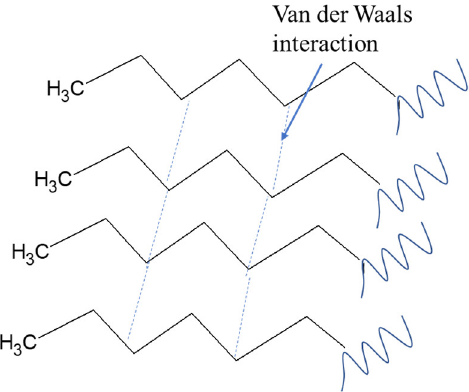
Figure 4. Hypothesis of Compounds interaction in diesel fuel [9].